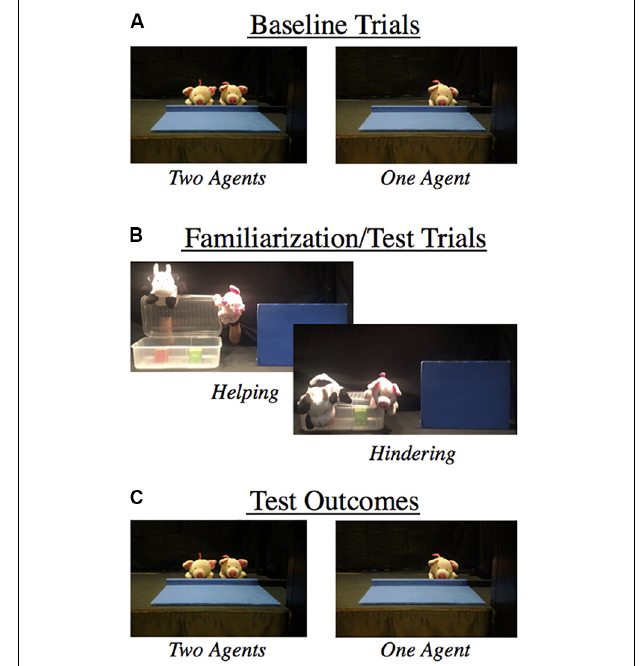
FIGURE 1 | An outline of the experimental design depicting the (A) baseline trials, (B) familiarization/test events, and (C) test outcomes of Experiment 1.